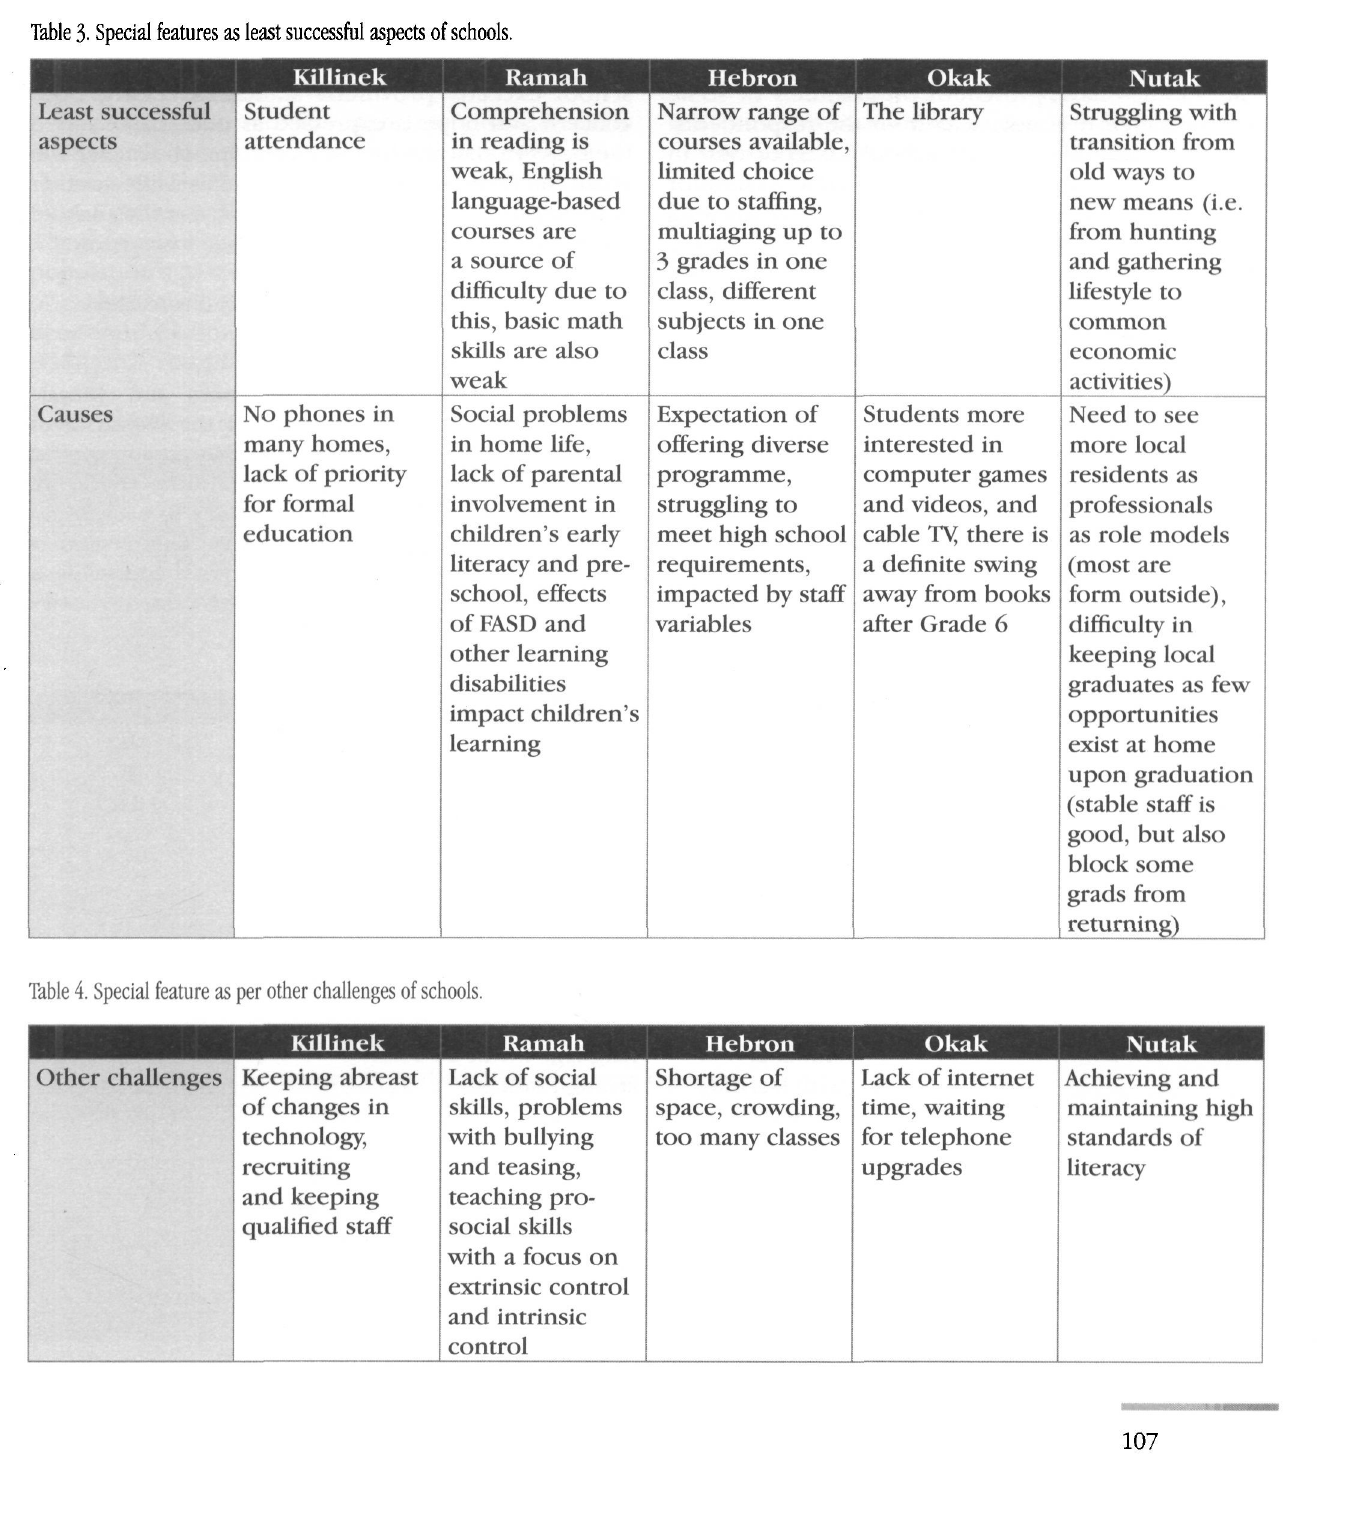
Table 3- Special features as least successful aspects of schools.